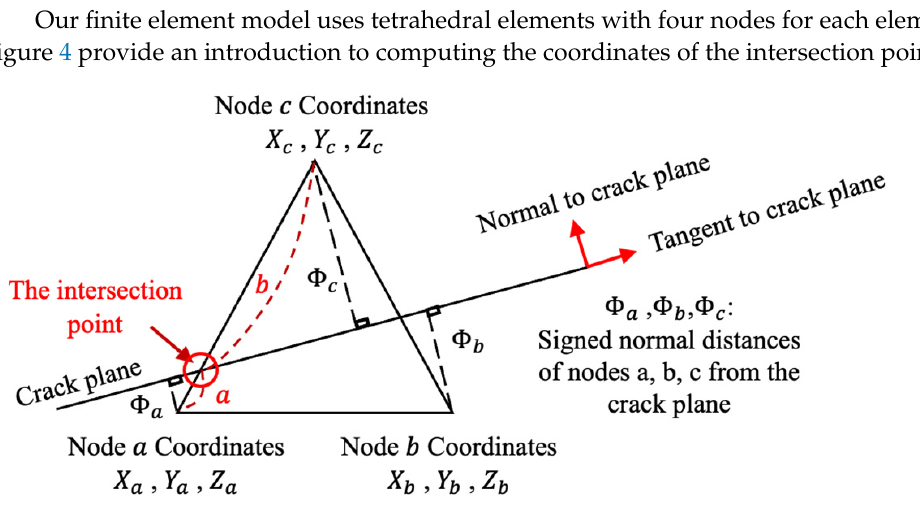
As shown in Figure 4, the PHILSM values of nodes a , b , and c are Φ a , Φ b , and Φ c .